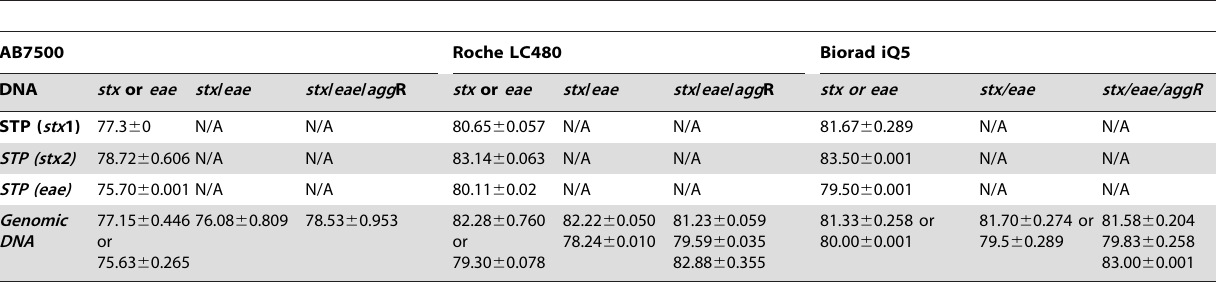
Table 1. Melting curve analysis of VTEC target plasmids and pure cultures of reference strains using the SYBR H Green Real-time simplex or multiplex reactions on an AB 7500, Biorad iQ5 and Roche LightCycler 480 PCR thermal cycler (STP: standard plasmid).